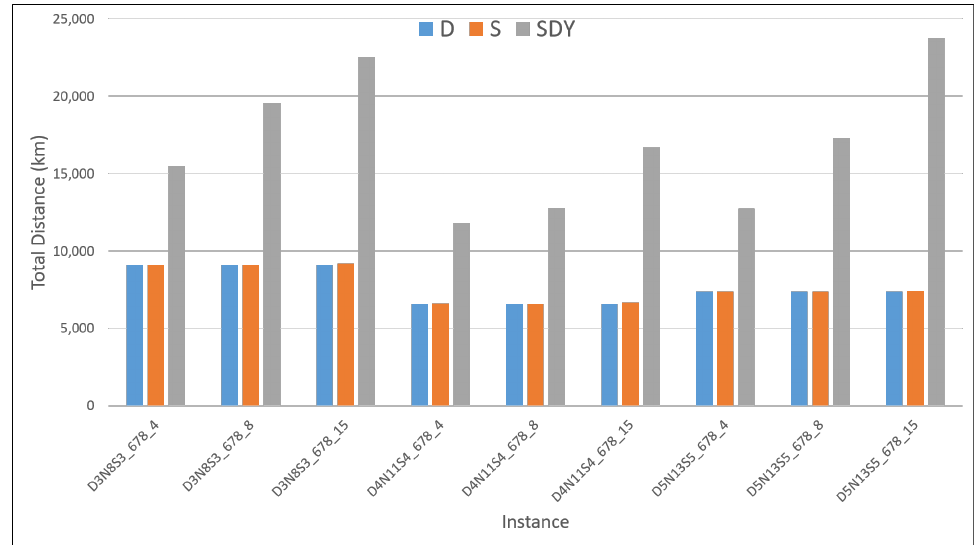
Figure A5. Total Distance Travelled for Maximum Road Capacity Setting ( 6,7,8 ) : Offline and Online Computation for all Instances based on Model Characteristic.